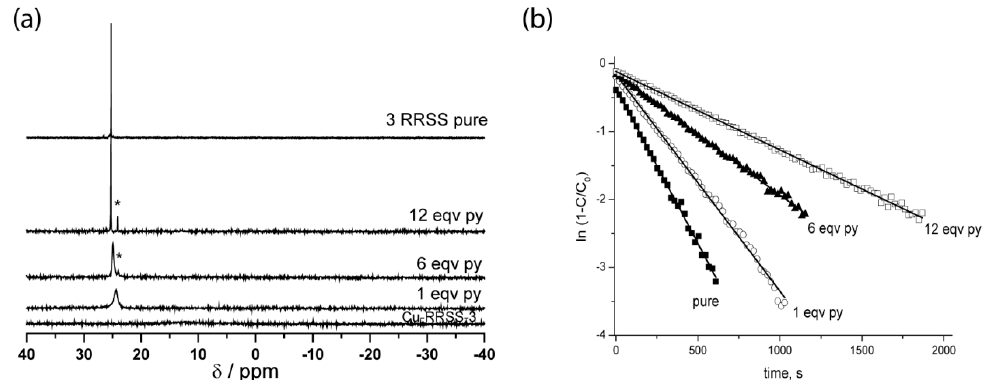
Figure 10. ( a ) Room temperature data on 31 P NMR spectroscopy at 0, 1, 6, and 12 equivalents of pyridine (from the bottom up) added to Cu- RSSR - 3 in C 6 D 6 (the asterisk denotes free ( RS / SR )- 3 as an impurity) and data on pure 3-RRSS; ( b ) Kinetics of Cu- RSSR - 3 decomposition in the presence of 3 eq. of TEMPO after gradual addition of pyridine (py) as a competitor. Adapted from Ref. [44] with permission from The Royal Society of Chemistry.